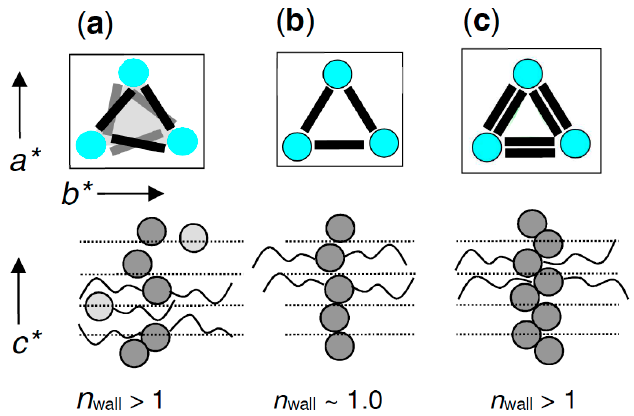
Figure 7. Cross-sections through one prismatic cell with view along direction c* (upper row) and through a single honeycomb wall perpendicular to c* (lower row, the gray cycles represent cuts through the OPE cores perpendicular to their long axes; the horizontal dotted lines indicate the height of each segment with h = 0.45 nm; ( a ) weakly segregated structure with additional disordered molecules filling the space in the triangular cells (light gray); ( b ) well-segregated structure with a single molecule in the lateral cross-section of the walls; and ( c ) laterally staggered organization, allowing dense packing of the aromatics and retaining the capability of all lateral chains to escape into the prismatic cells. Table 2. Comparison of the mesophases, phase transition temperatures ( T /°C) as observed on heating (top lines) and cooling (bottom lines), the corresponding enthalpy values ( Δ H /(kJ·mol − 1 ), in square brackets), and other data of compounds D and E , with fluorinated lateral chains a .